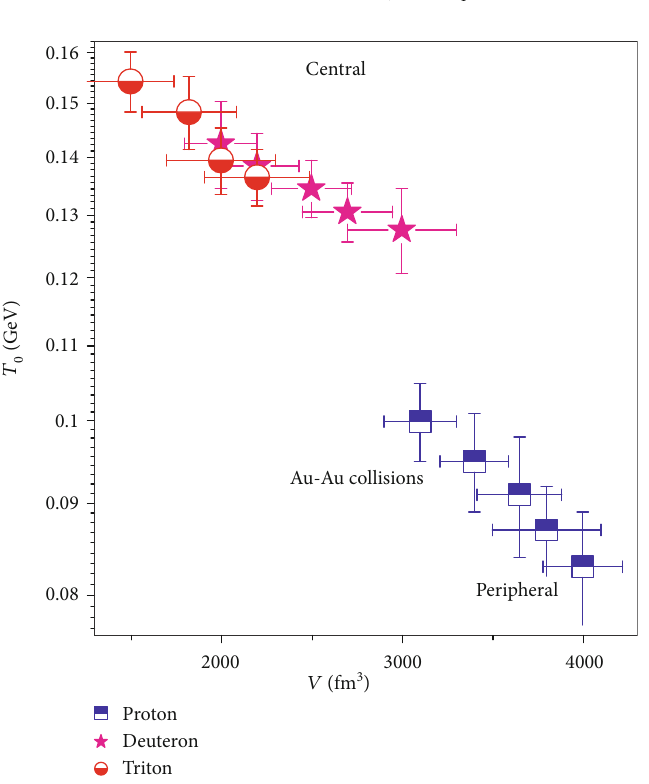
Figure 5: Variation of T